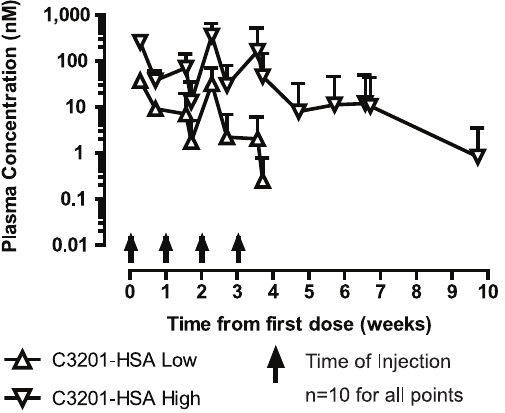
Figure 6. Analysis of C3201-HSA serum levels in C3201-HSA in vivo functional study. Mean serum concentration of C3201-HSA in low and high dose groups determined by specific sandwich ELISA. N=10 for both groups. Data are represented as mean + / 2 SEM